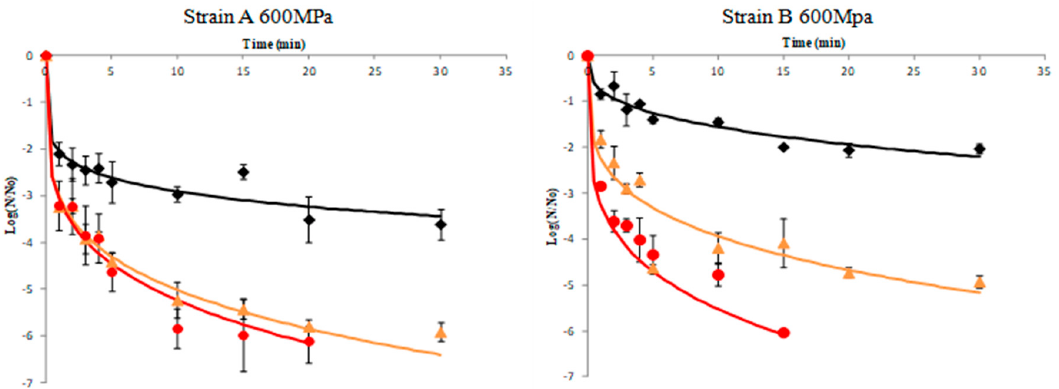
Figure 2. Inactivation curves of A. acidoterrestris spores at 600 MPa and 45 °C ( ◆ ), 60 °C ( ▲ ) and 70 °C ( ● ). Solid lines represent data fi tt ing with the Weibull model. Data are mean values of two replications ± standard deviation.